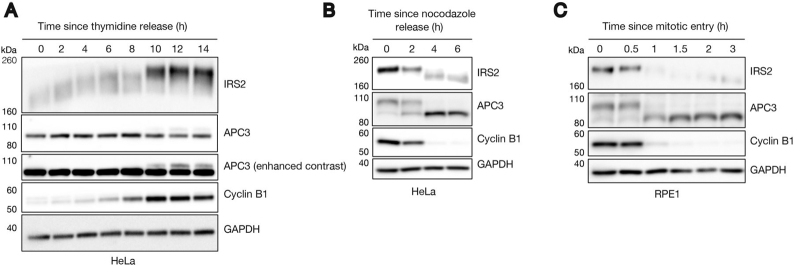
IRS2 levels and phosphorylation fluctuate in a cell-cycle dependent manner.A, HeLa cells were synchronized by double thymidine block and released into S-phase in the presence of nocodazole. Lysates were harvested and analyzed by immunoblotting for IRS2 and cell cycle markers. B, HeLa cells were synchronized by single thymidine-nocodazole block and released into prometaphase. Mitotic cells were collected by mitotic shake-off and re-plated. Time points were taken every two hours as cells exited M-phase. Lysates were harvested and analyzed by immunoblotting for IRS2 and cell cycle markers. C, RPE1 cells were synchronized in G2 by treatment with the Cdk1 inhibitor RO3306. After 18 h, cells were switched to fresh media and were allowed to enter mitosis (∼35 min following drug removal). At mitotic entry, cells were collected by mitotic shake-off and were re-plated (0 h). Time points were taken as cells exited M-phase and entered G1. Lysates were harvested and analyzed by immunoblotting for IRS2 and cell cycle markers.